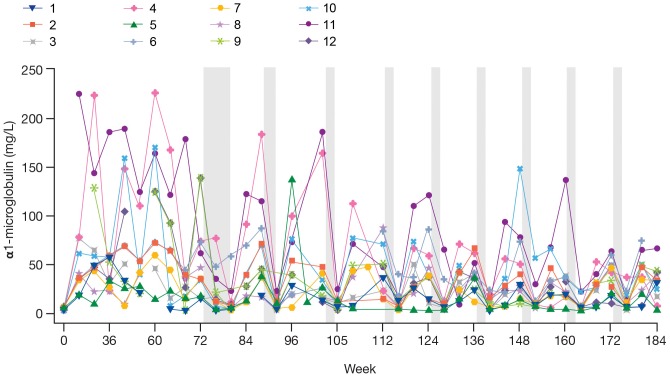
α1-Microglobulin levels over 177 weeks.Subjects 1, 2, 5, 6, 7, 9, and 12 walked ≥330 m at extension study baseline; subjects 3, 4, 8 10, and 11 walked <330 m at extension study baseline. Grey shading is representative of off-treatment periods.